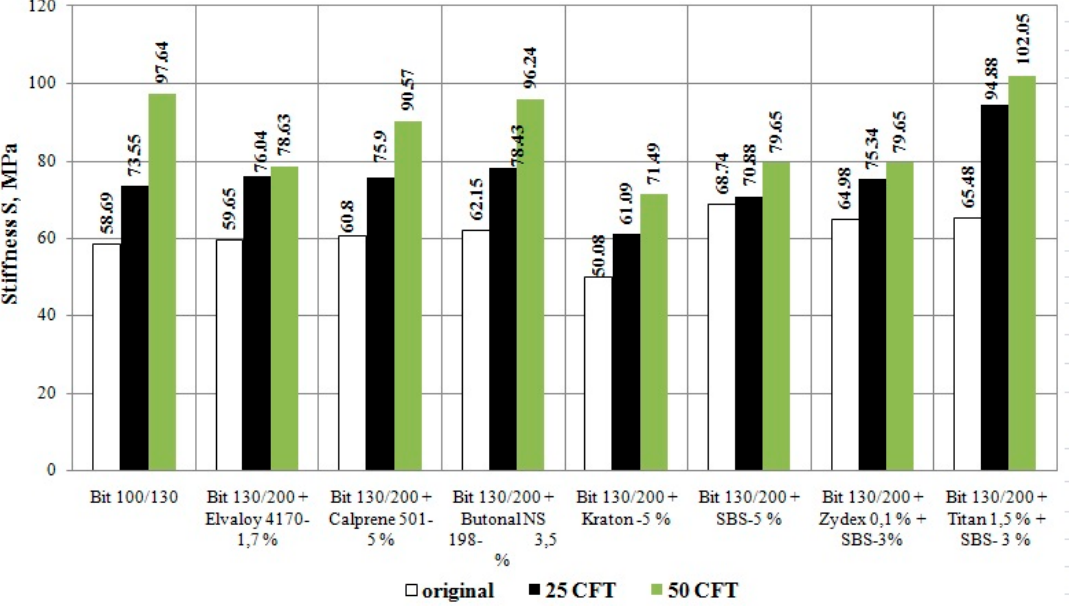
Figure 13. Bitumens stiffness at the temperature of –24° С .